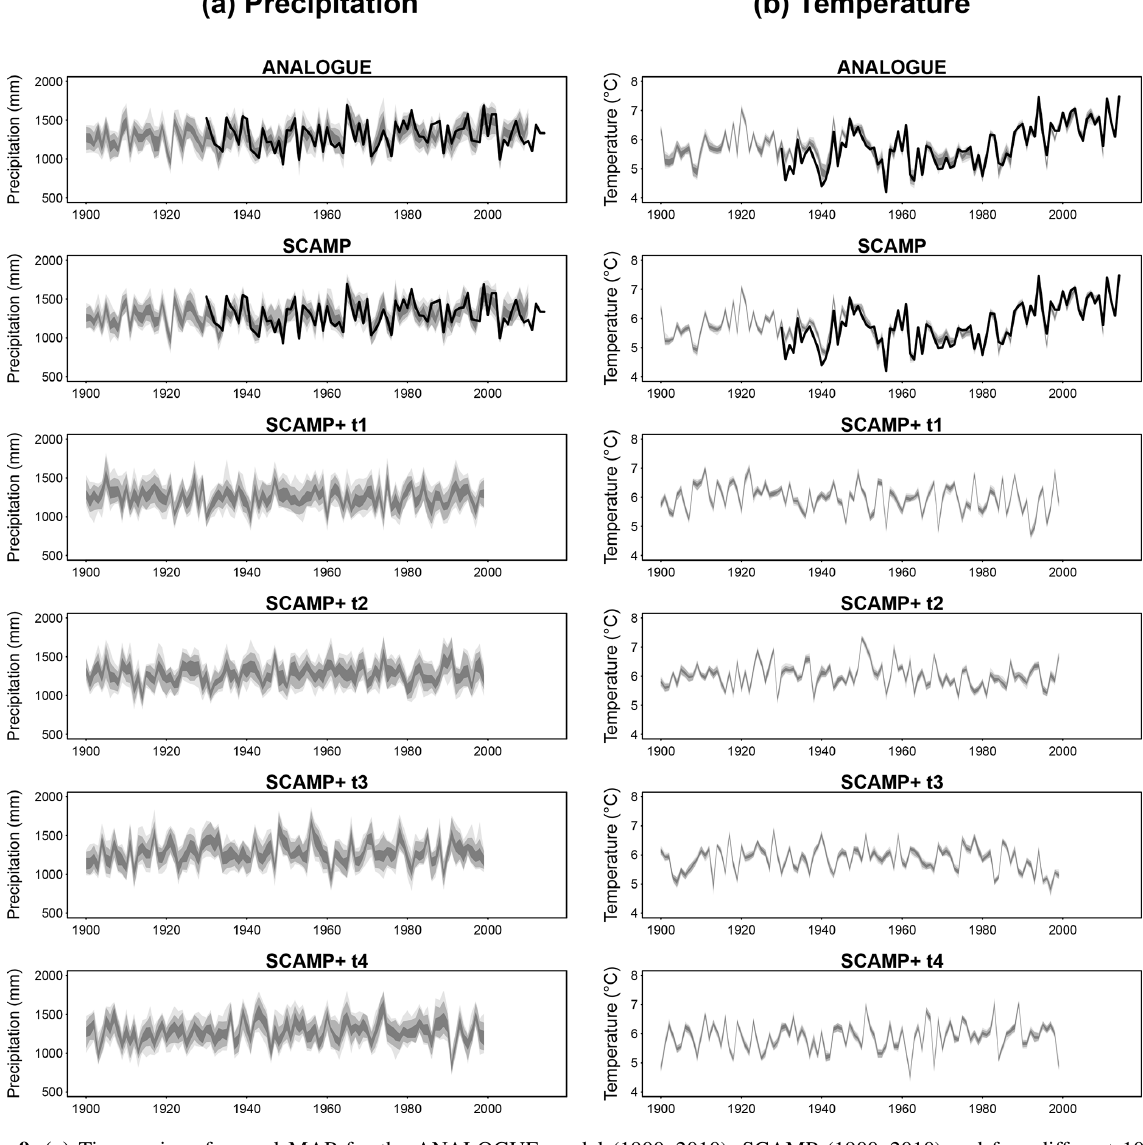
Figure 9. (a) Time series of annual MAP for the ANALOGUE model (1900–2010), SCAMP (1900–2010) and four different 100-year atmospheric trajectories (t1, t2, t3 and t4) of SCAMP + . The observed annual MAP (1930–2014) is presented with the black solid line in the plots associated with ANALOGUE and SCAMP models. The grey shadings present the inter-quantile intervals at 50%, 90% and 99% levels (30 × 111-year scenarios for models ANALOGUE and SCAMP and 30 × 100-year scenarios for SCAMP + ). (b) Time series of annual MAT for the ANALOGUE model (1900–2010), SCAMP (1900–2010) and four different 100-year atmospheric trajectories of SCAMP + . The observed annual MAT (1930–2014) is presented with the black solid line in the plots associated with ANALOGUE and SCAMP models. The grey shadings present the inter-quantile intervals at 50%, 90% and 99% levels (30 × 111-year scenarios for models ANALOGUE and SCAMP and 30 × 100-year scenarios for SCAMP +